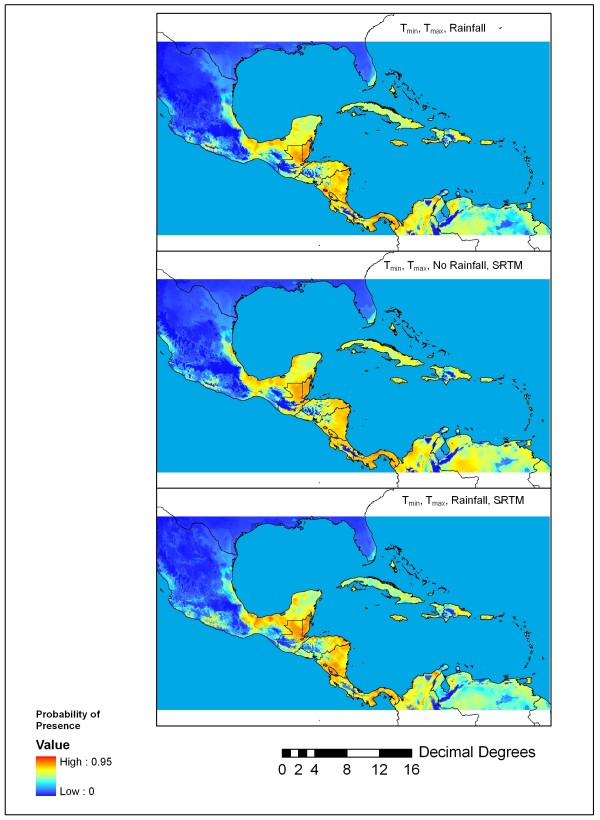
Probability ofAn. albimanuspresence obtained in three different experiments. Top panel: experiment 56 (monthly Tmin, Tmax, rainfall); middle panel: experiment 58 (monthly Tmin, Tmax, SRTM); bottom panel: experiment 61 (monthly Tmin, Tmax, rainfall and SRTM).